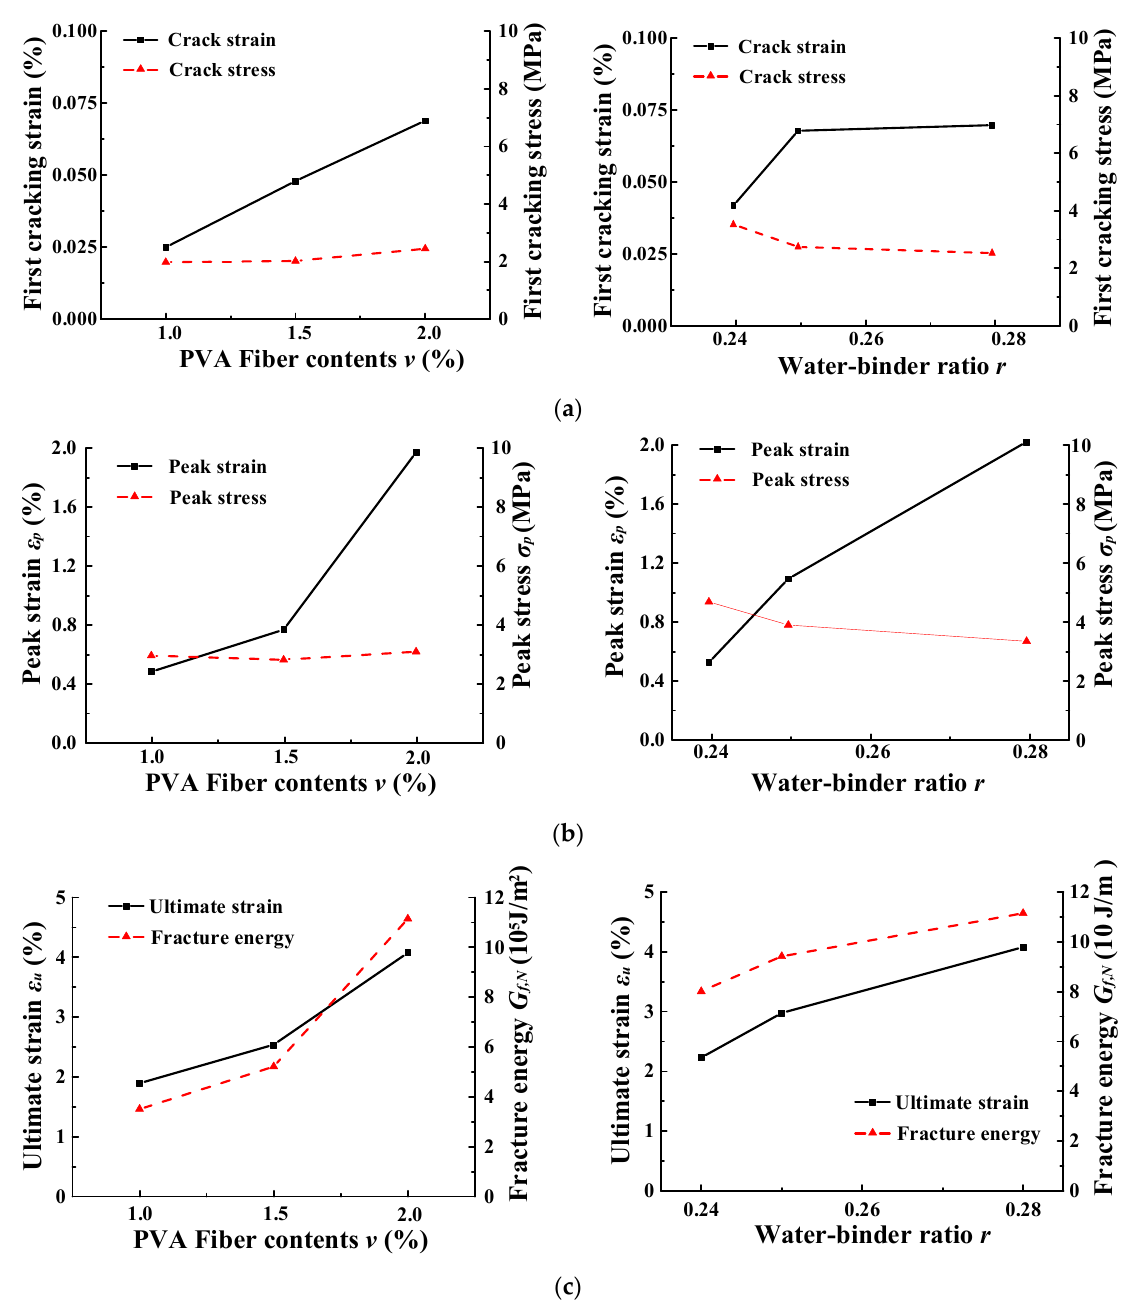
Figure 2. ECC tensile properties: ( a ) First cracking strain and stress; ( b ) Peak strain and stress; ( c ) Ultimate strain and fracture energy.